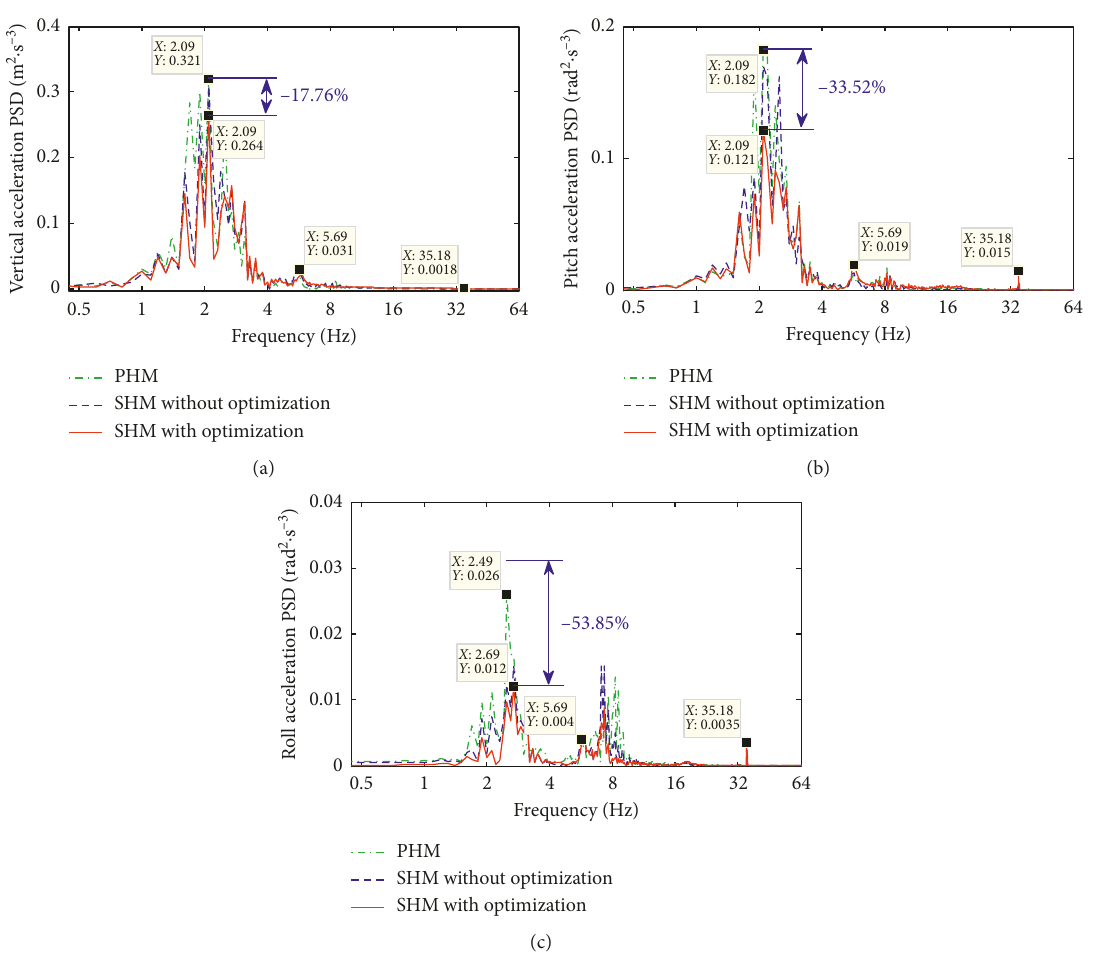
Figure 11: Results of the PSD acceleration responses under a high excitation frequency, 35Hz, of the drum. (a) Vertical driver’s seat. (b) Cab’s pitch angle. (c) Cab’s roll